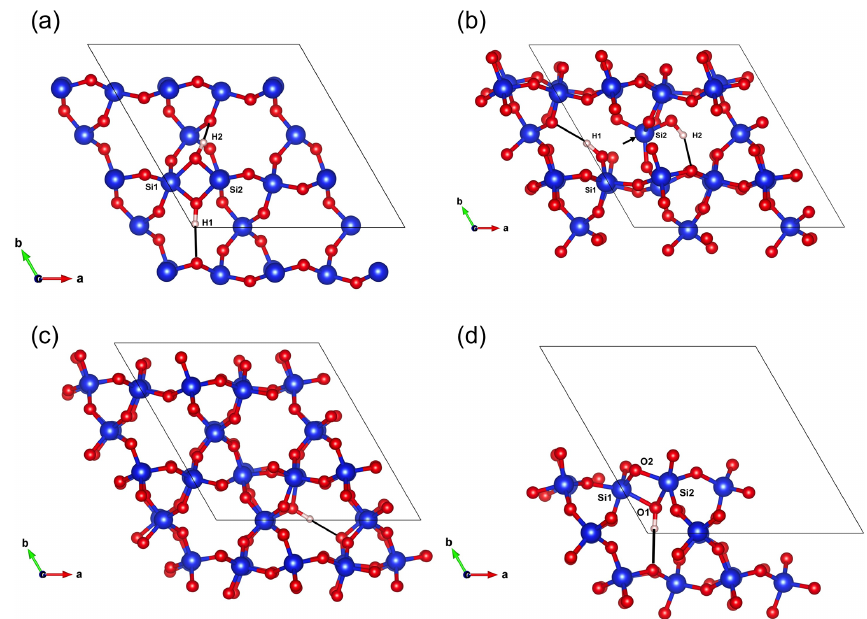
Figure 5. (a) Structure of the Griggs_1 defect. Note the asymmetric pair of OH groups bridging the fivefold coordinated Si1 and Si2 atoms. (b) Structure of the Griggs_2 defect. The arrow indicates the displacement of Si2 atom to an interstitial position. (c) Structure of the H + defect. (d) Structure of the OH − defect (Griggs_1_H1 model). The charge of the H + and OH − defects in (c) and (d) is compensated for by an electrostatic background homogeneously spread over the cell (see